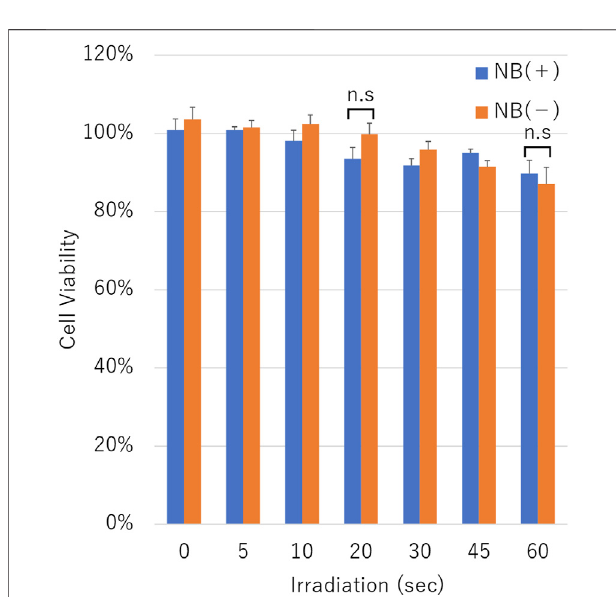
Frontiers in Pharmacology |